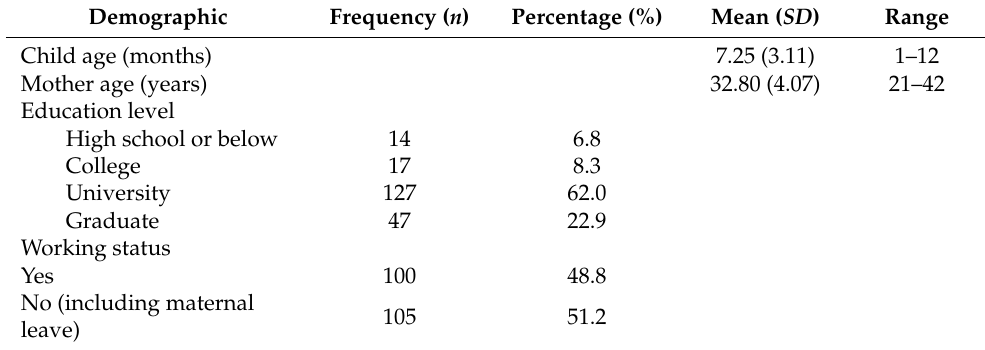
Table 1. Sample characteristics ( N =